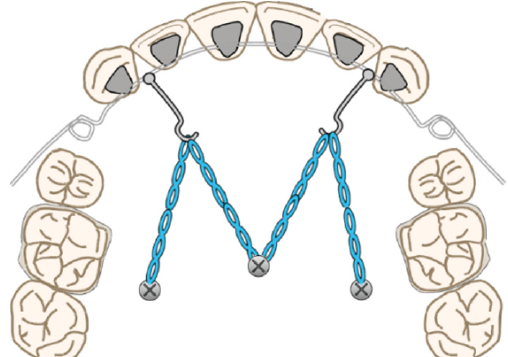
Figure 6. Schematic representation of the Double J retractor (DJR) designed to apply Class II elastics to the extended spring to the buccal side. Redrawn with permission from Semin Orthod [22].